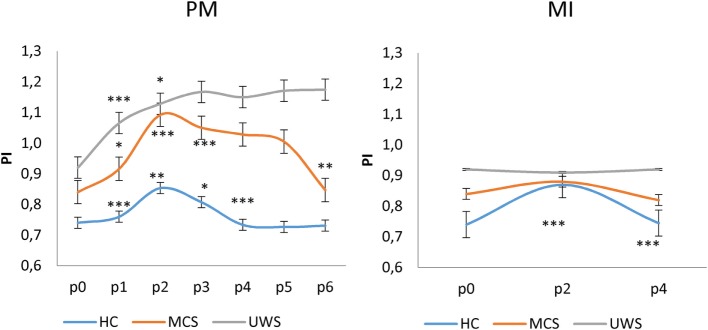
Shows mean (±SD; vertical error bar) pulsatility index (PI) values during passive movement (PM) and motor imagery (MI) tasks for each group [healthy controls (HC), minimally conscious state (MCS), and unresponsive wakefulness syndrome (UWS)] across the hand positions (p) explored. There was a significant difference at p0 (baseline) between the PI values of HCs and patients with disorders of consciousness (p < 0.001), and between patients with MCS and UWS (p = 0.01). PM induced a significantly different PI modulation at each p among the groups (p < 0.001). On the contrary, MI induced a significant increase of PI at p2 and decrease at p4 only in the HCs. *Refer to the significance of intragroup PI change at each p as compared to the previous one (Bonferroni corrected p-value, ***p < 0.001, **p = 0.001, *p < 0.0125).